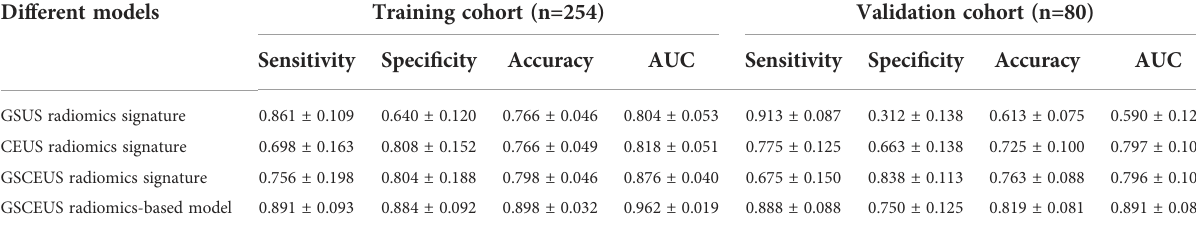
TABLE 3 Predictive ef fi cacy of radiomics signature and the radiomics-based model. Different models